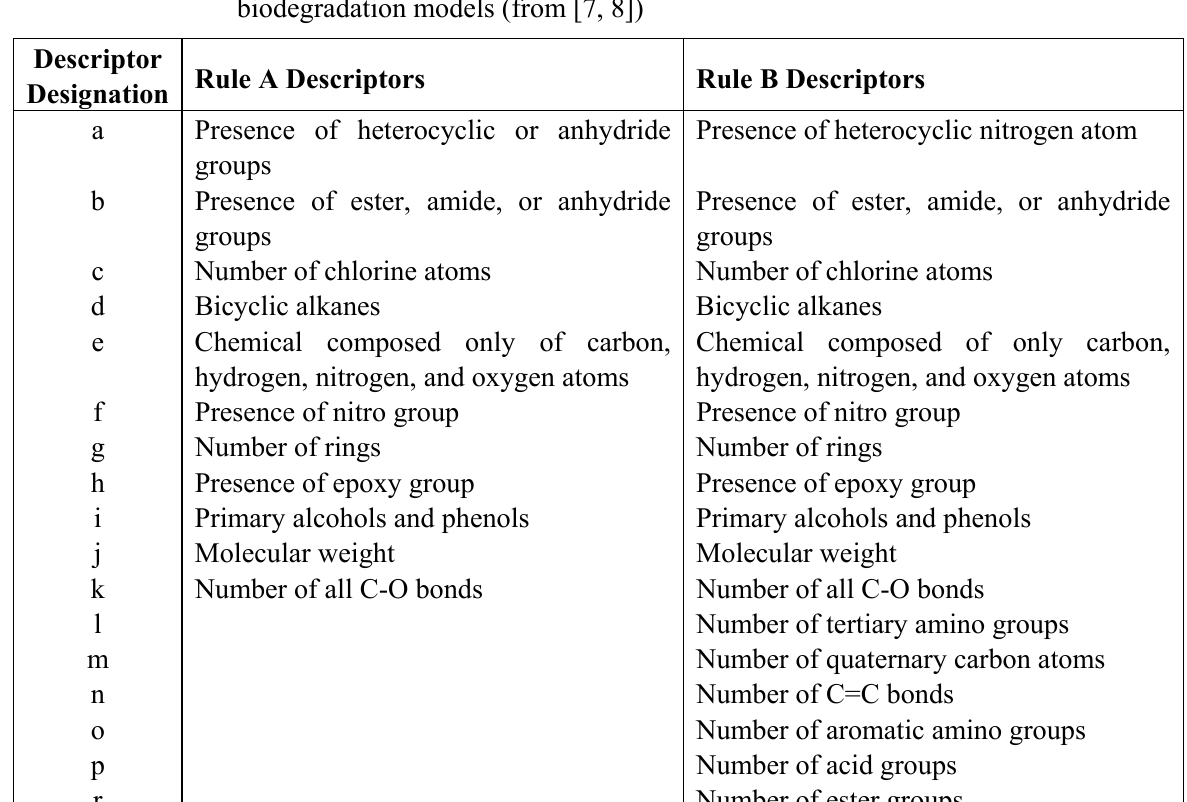
Structural descriptors used in construction of Artificial Intelligence biodegradation models (from [7, 8])